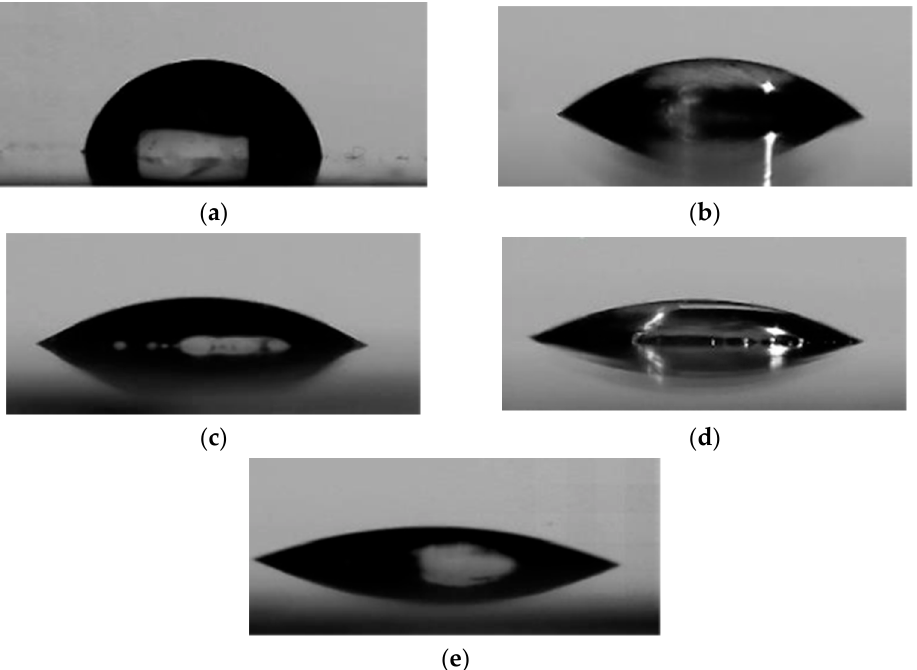
Figure 9. Images of water droplets on the surface of ( a ) COC, and GO − coated COC with GO suspension concentrations of ( b ) 1 mg/mL, ( c ) 2 mg/mL, ( d ) 3 mg/mL, and ( e ) 4 mg/mL at 5 min plasma exposure time. Results were collected immediately after the wafer was fabricated.